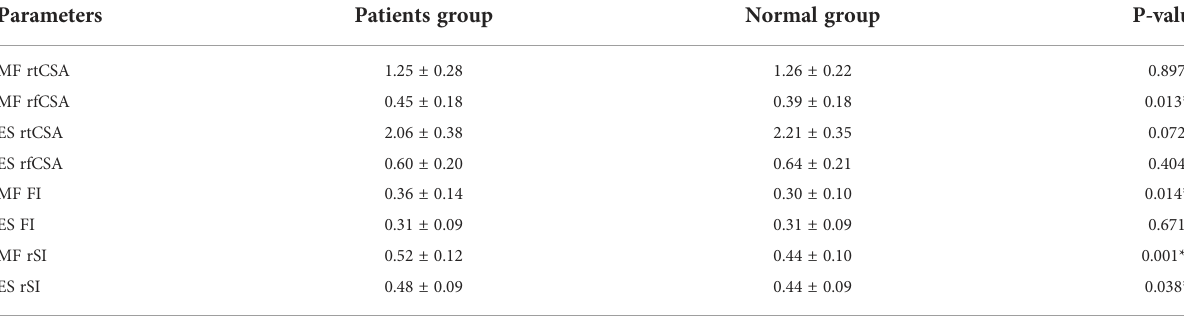
TABLE 3 The mean values of paraspinal muscle